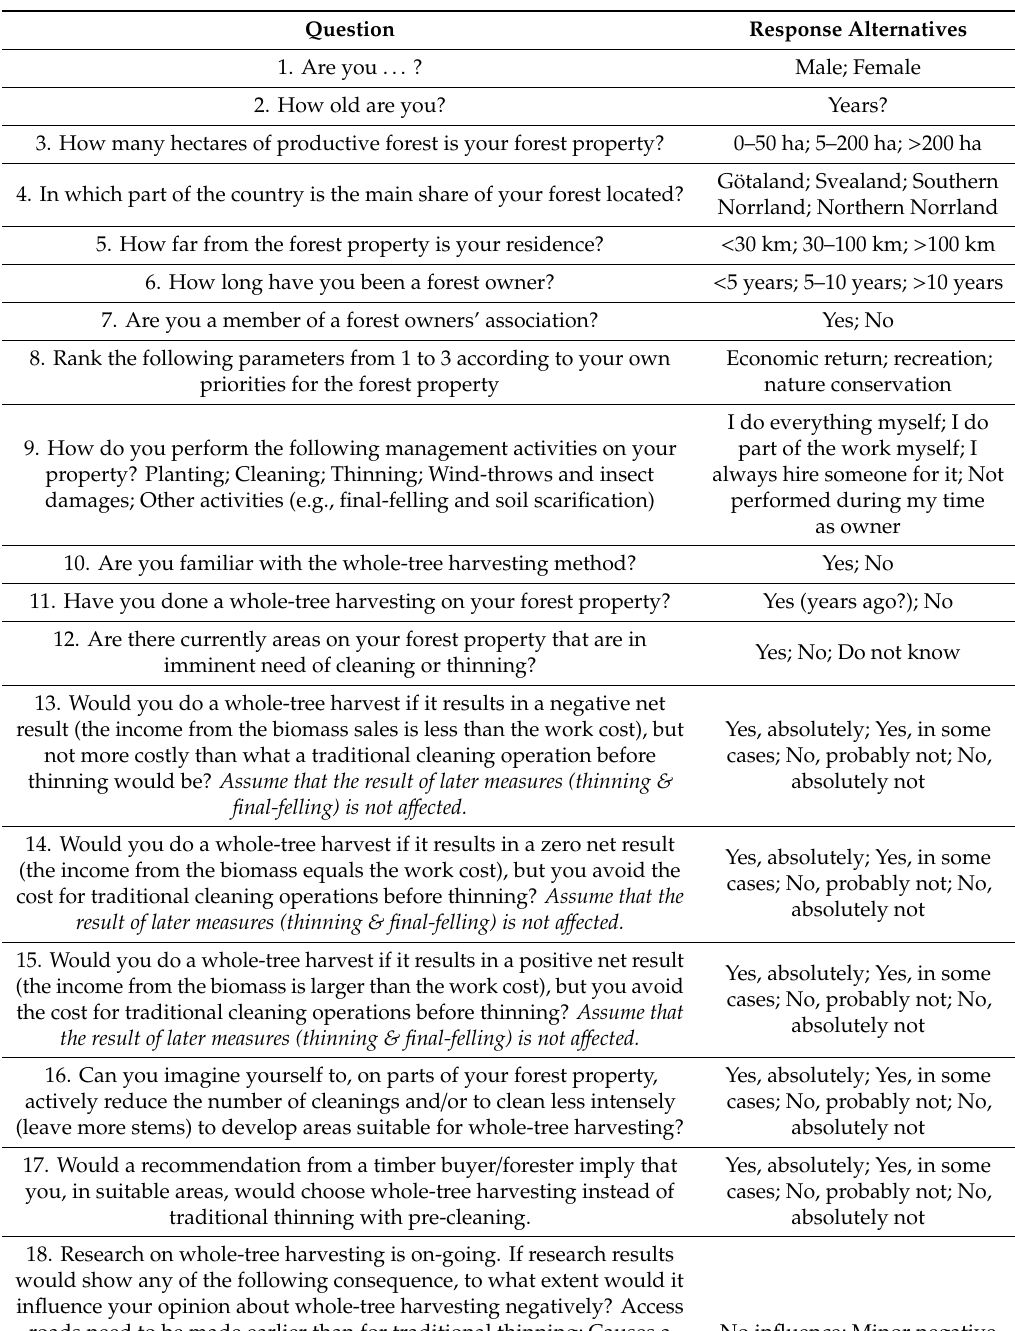
Table 2. Questions and response alternatives in the questionnaire (translated from